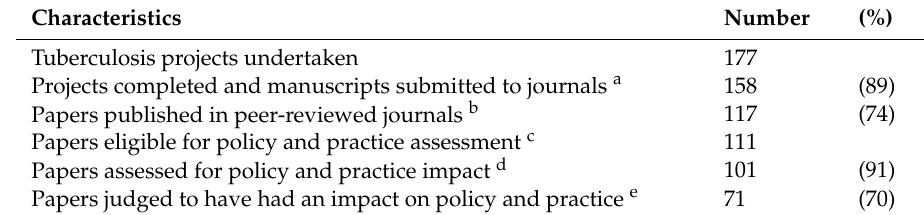
Table 6. Tuberculosis research projects generated through SORT IT courses in the Asia Pacific Region: 2009–2018.